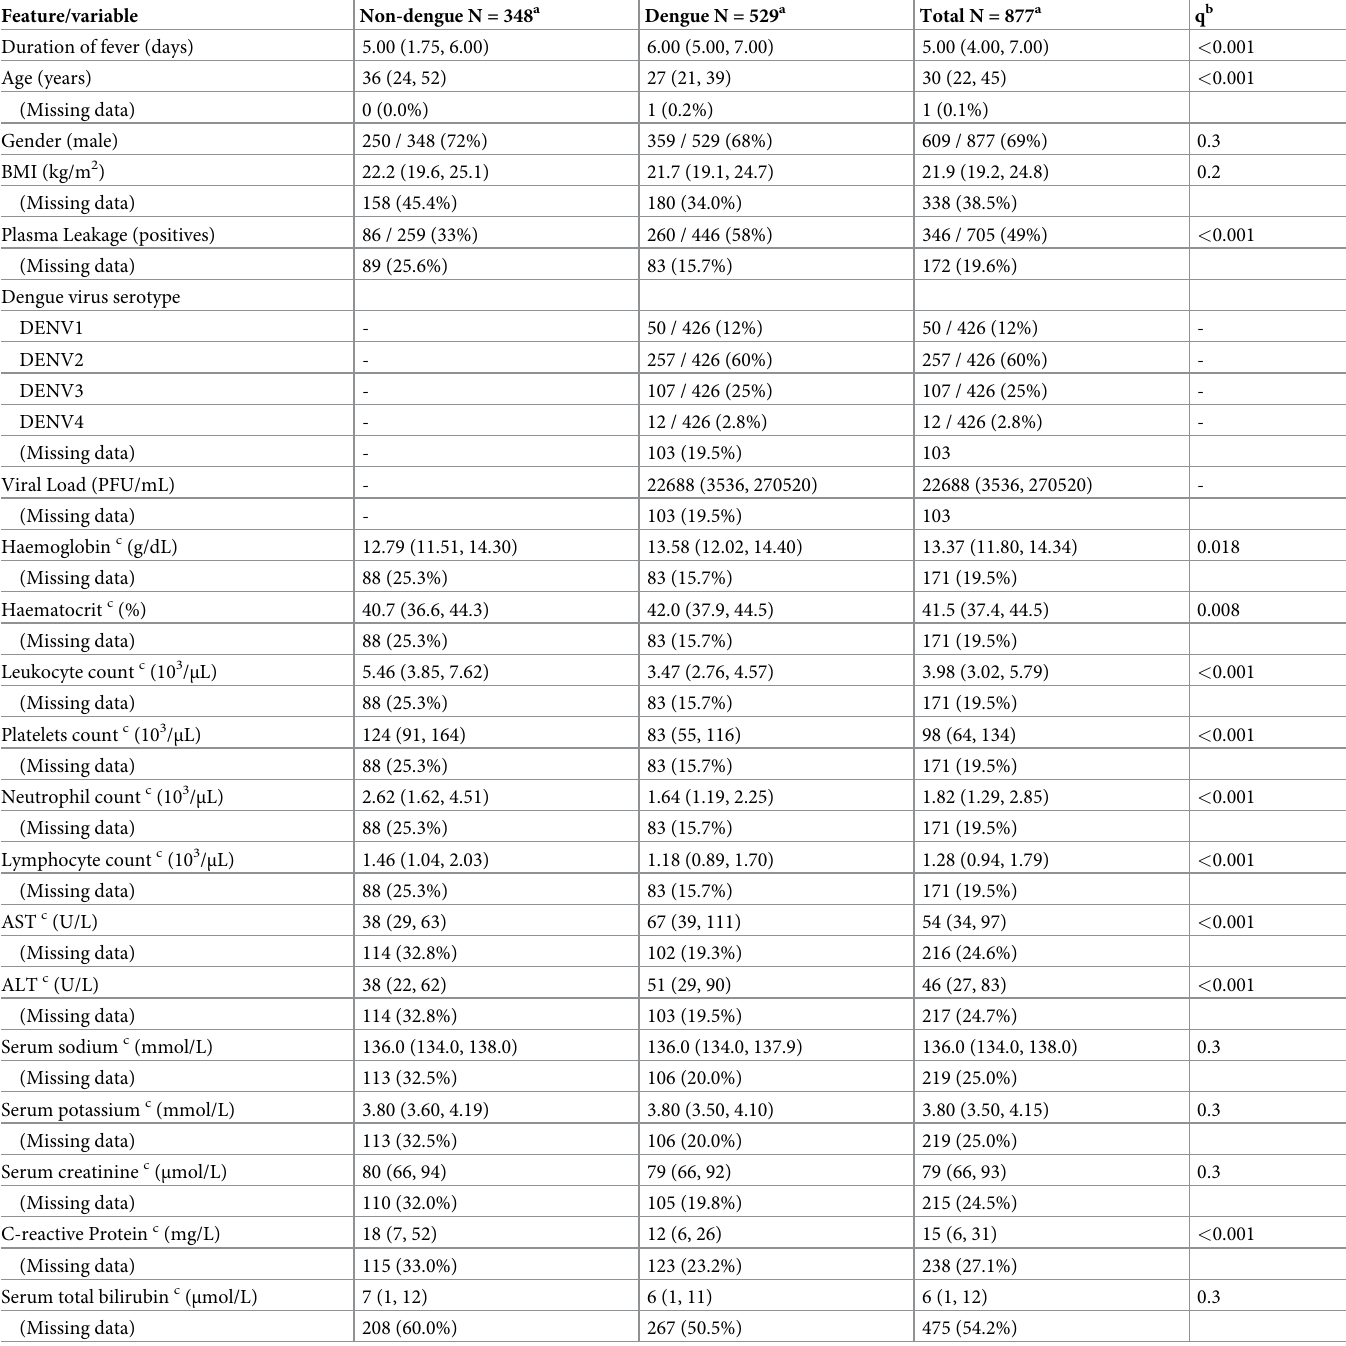
Table 1. Summary statistics of cohort grouped by dengue and non-dengue